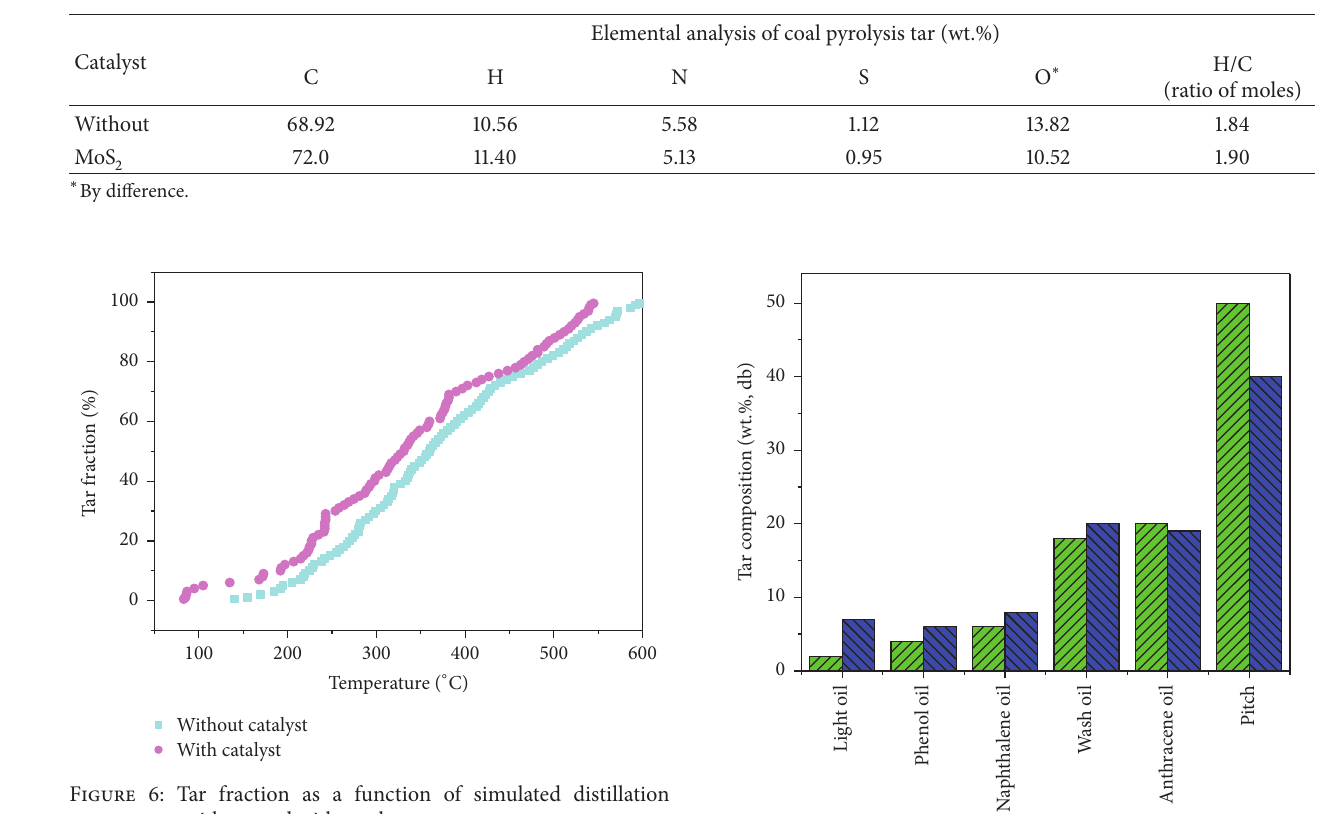
Table 2: Analysis of produced coal pyrolysis tars before and after reaction.